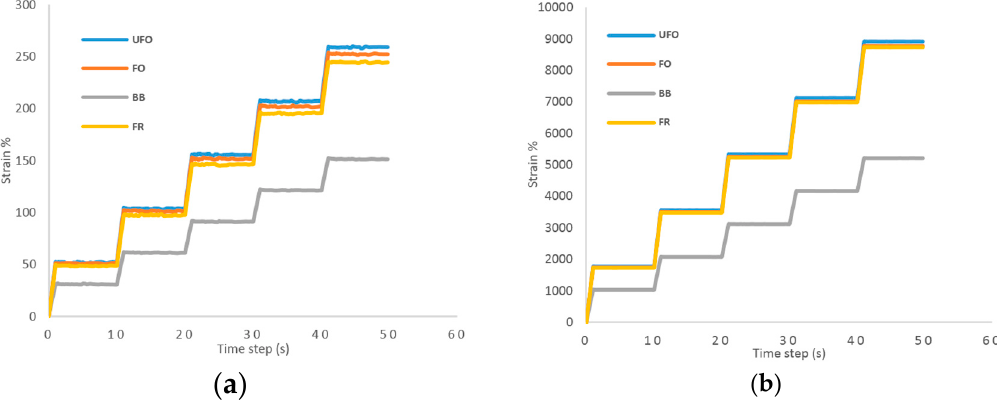
Figure 11. Five cycles of creep and recovery at 64 °C ( a ) with 0.1 kPa stress and ( b ) with 3.2 kPa stress.